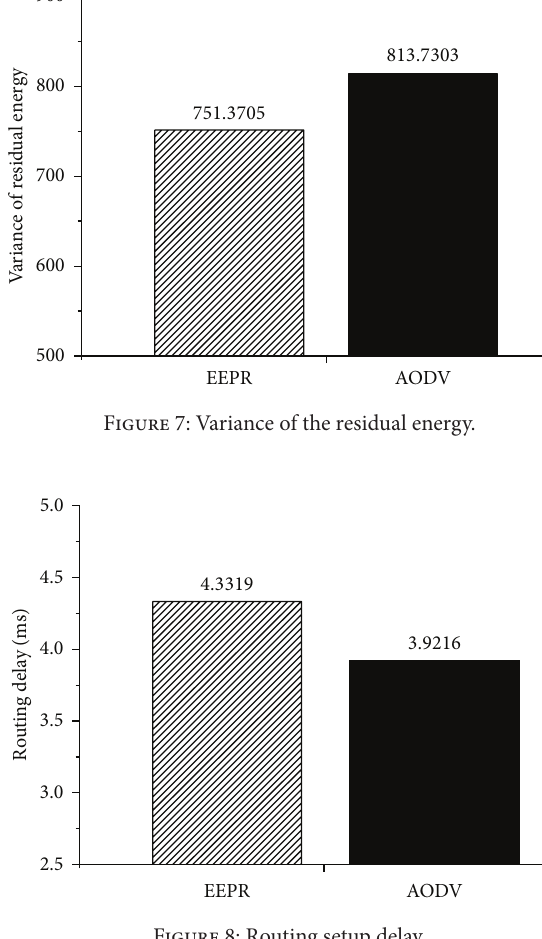
Figure 8: Routing setup